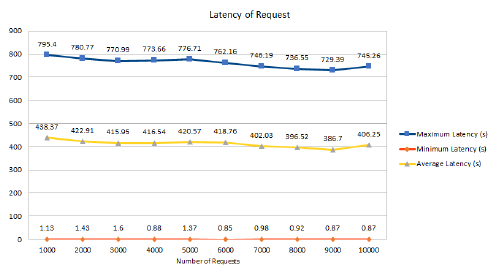
Figure 9. The latency of the update data